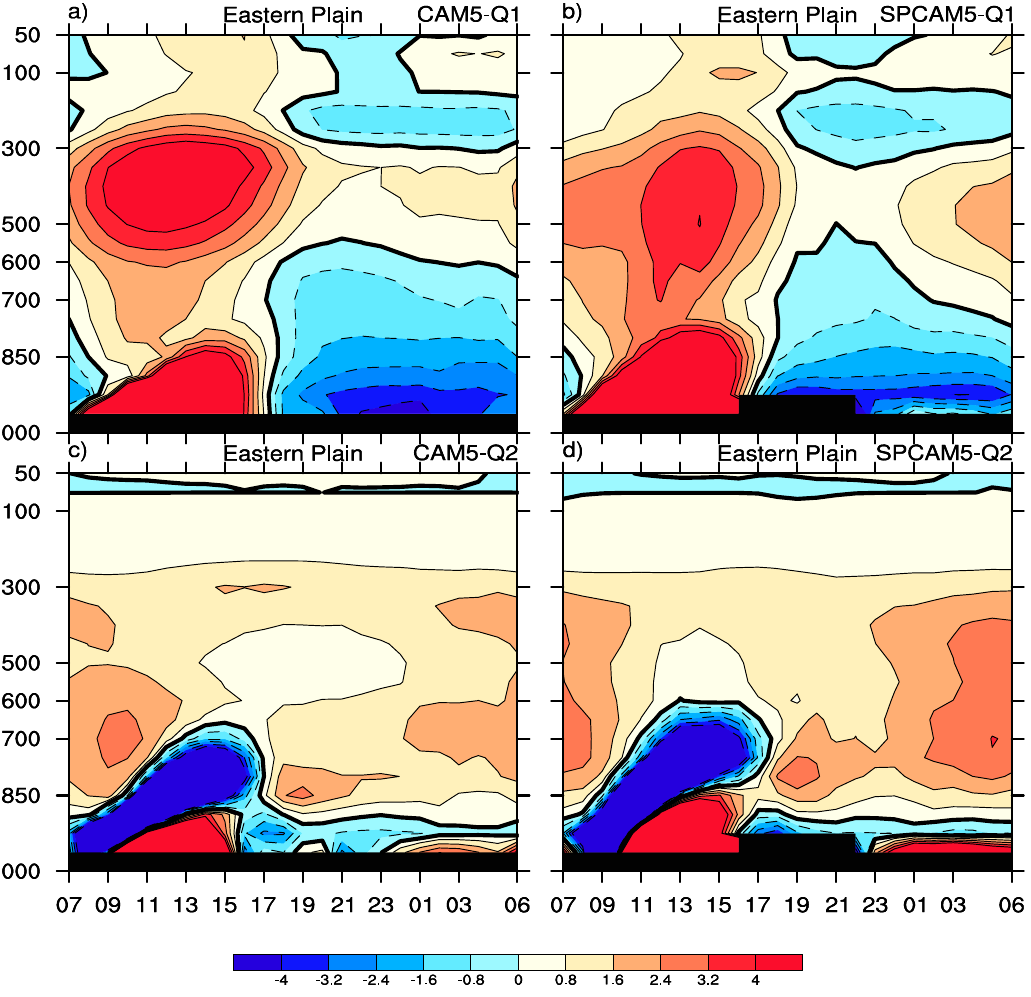
Figure 5. The hour–pressure transects (eastern plain) of apparent heat source ( Q 1 ) and apparent moisture sink ( Q 2 ) averaged within 32–36 ◦ N, 113–118 ◦ E, ( a ) Q 1 in CAM5, ( b ) Q 1 in SPCAM5, ( c ) Q 2 in CAM5, ( d ) Q 2 in SPCAM5, unit: K · day − 1